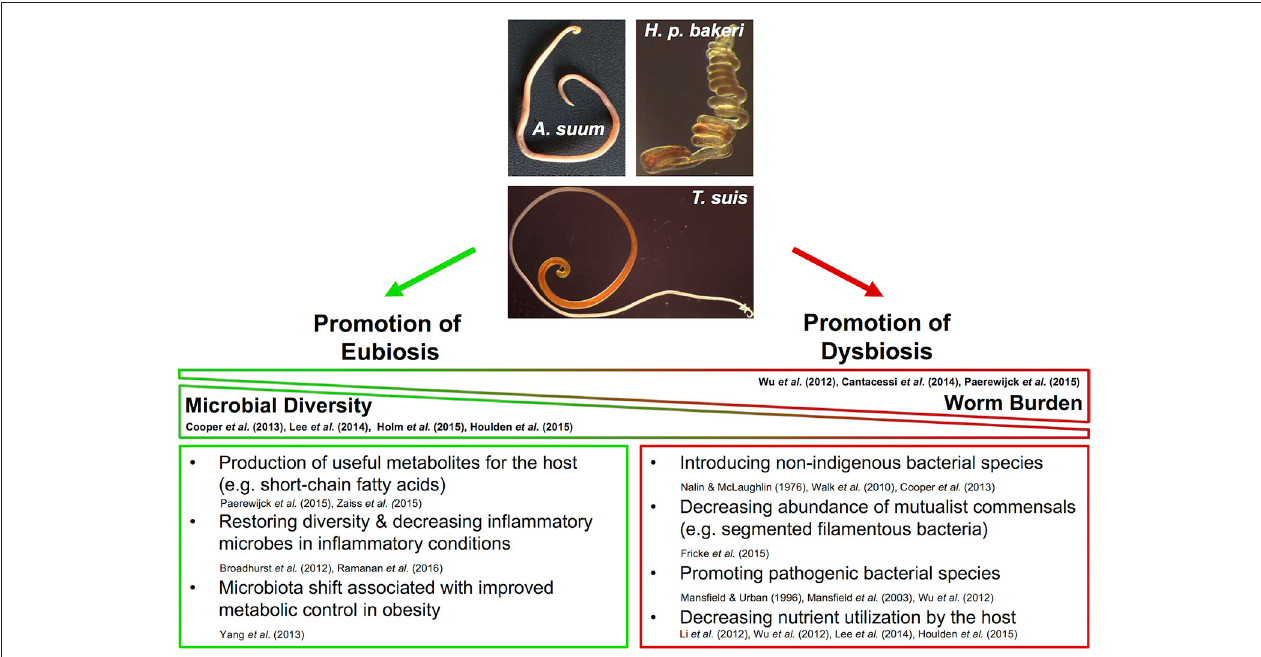
FIGURE 1 | Diverse influences of nematodes on the gut microbiota of their hosts.